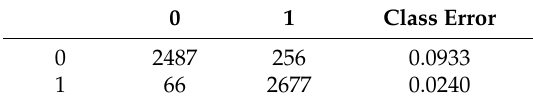
Table 4. Confusion matrix from the random forest (RF) model (0 = no gully, 1 = gully).